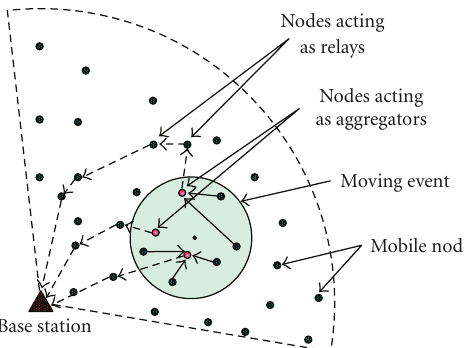
Figure 2: Schematic of proposed DVD for moving event localiza- tion in Multihop Cellular Sensor